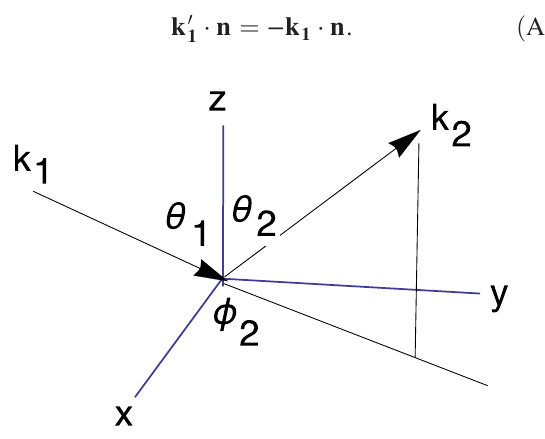
FIG. 18. Coordinate system illustrating the vectors k 1 and k 2